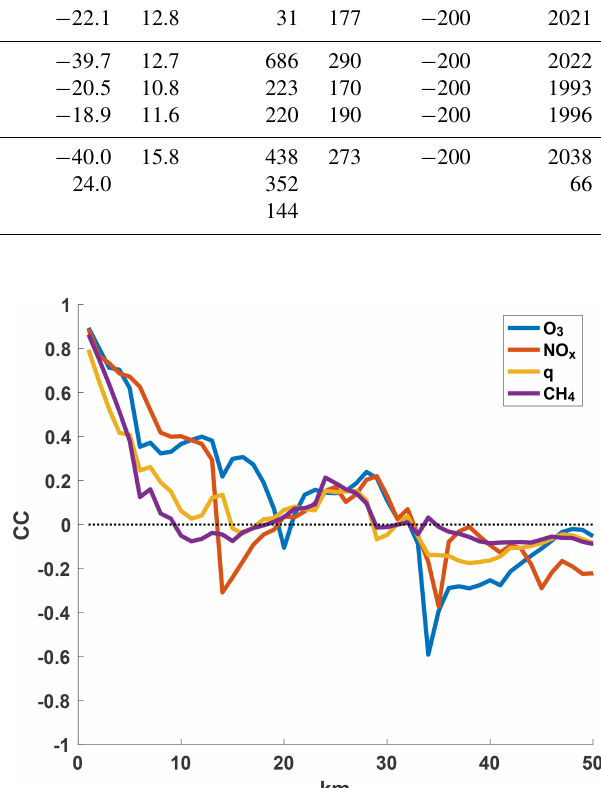
Figure 12. Spatial correlation plot corresponding to the patchiness plot from 27 July 2016. The y axis shows the correlation coefficient (CC) and the x axis shows the distance in kilometers for which the data have been correlated. q signifies water